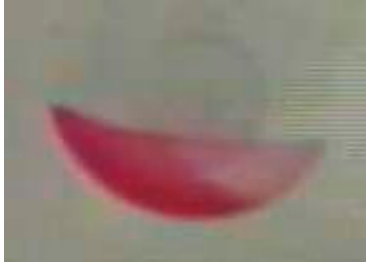
Figure 8. Image of the mixing chamber after the disc was spun after 15 s without using the compression-releasing mechanism. The standard derivation was calculated to be 0.25.